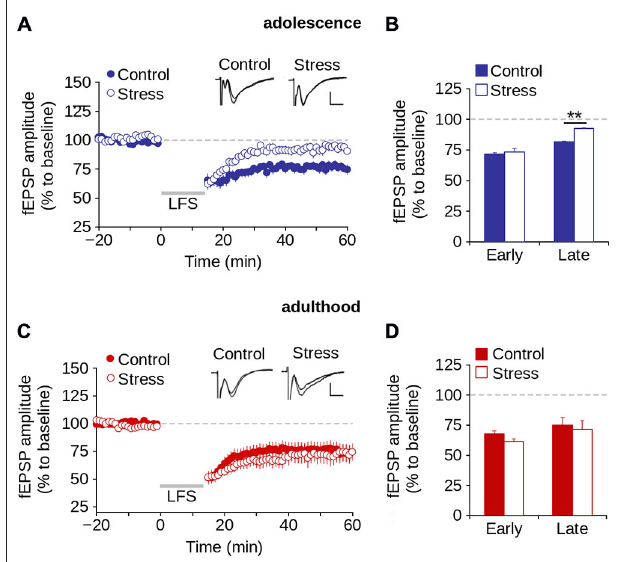
FIGURE 7 | Repeated stress-induced impairment of the LTD in layer 1 of mPFC during adolescence is reversed in adulthood. (A,B) Time lapse of normalized fEPSP amplitude expressed as a percentage of the baseline for control and stress conditions during adolescence (A) and adulthood (B) . Inset: representative superimposed traces from control and stress groups before and after the application of the LFS protocol (indicated by the gray bar). Calibration bar: 0.5 mV; 5 ms. (C,D) Bar chart of the average normalized fEPSP amplitude recorded during the first 10 min (early-LTD) and last 10 min (late-LTD) after the application of the LFS protocol for control and stress conditions during adolescence (C) and adulthood (D) ( ∗∗ p < 0.05; Bonferroni post hoc comparison). Data are expressed as mean ± SEM ( n = 4 animals per group; 10-11 slices per group). either early (control = 59.8 ± 5.5%; stress = 53.2 ± 3.7%; p >